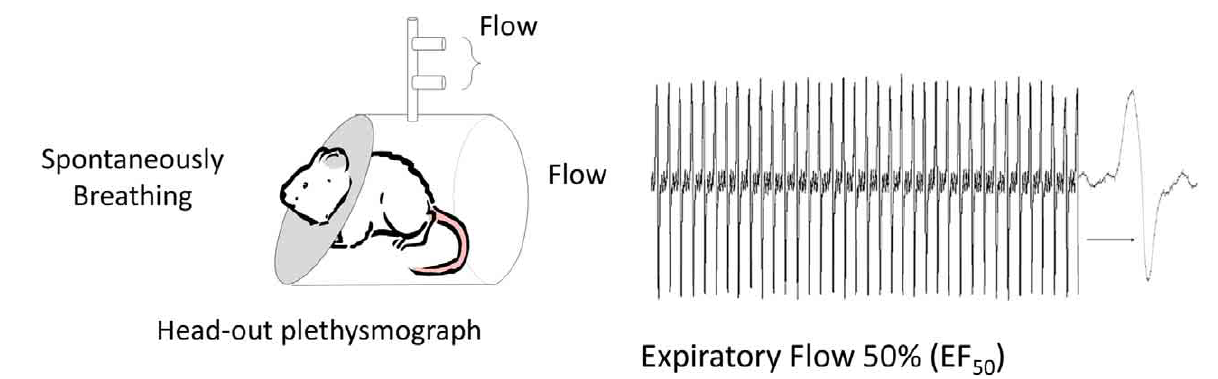
FIGURE 2 | Non-invasive method to measure respiratory mechanics. Mid-Expiratory Flow: Flow is measured at 50% of the expired volume (EF 50 ) from animals placed in a head-out plethysmograph. A pneumotach placed in the chamber, face mask (in humans) or tracheal cannula can be used to measure flow and volume